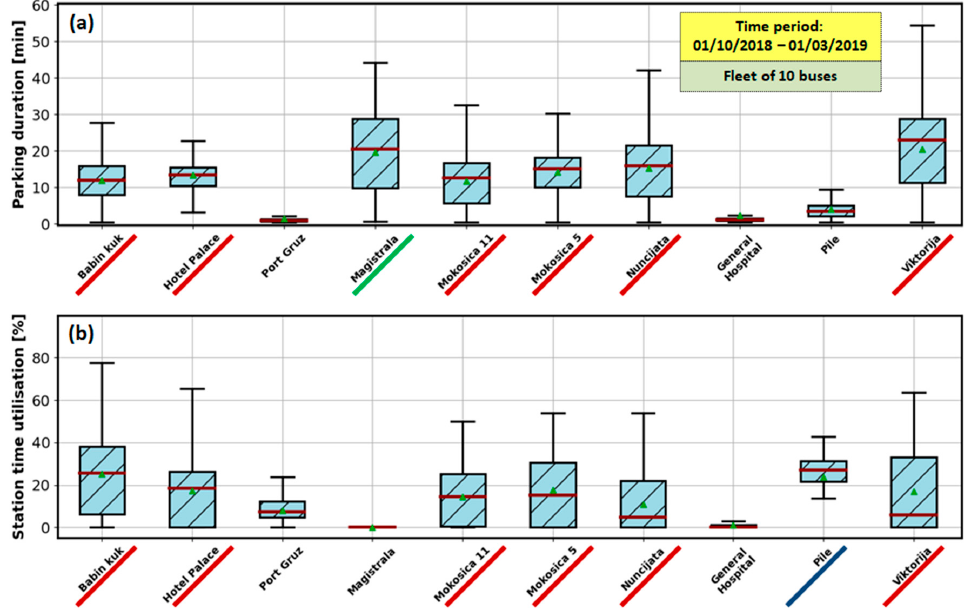
Figure 7. Boxplots of time duration of buses being parked at different end stations ( a ) and end stations charging utilisation ( b ).